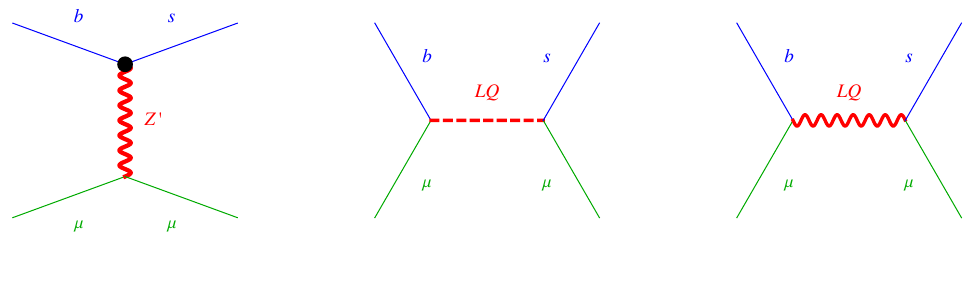
Figure 6 . Particles that can mediate R K at tree level: a Z 0 or a lepto-quark, scalar or vector.